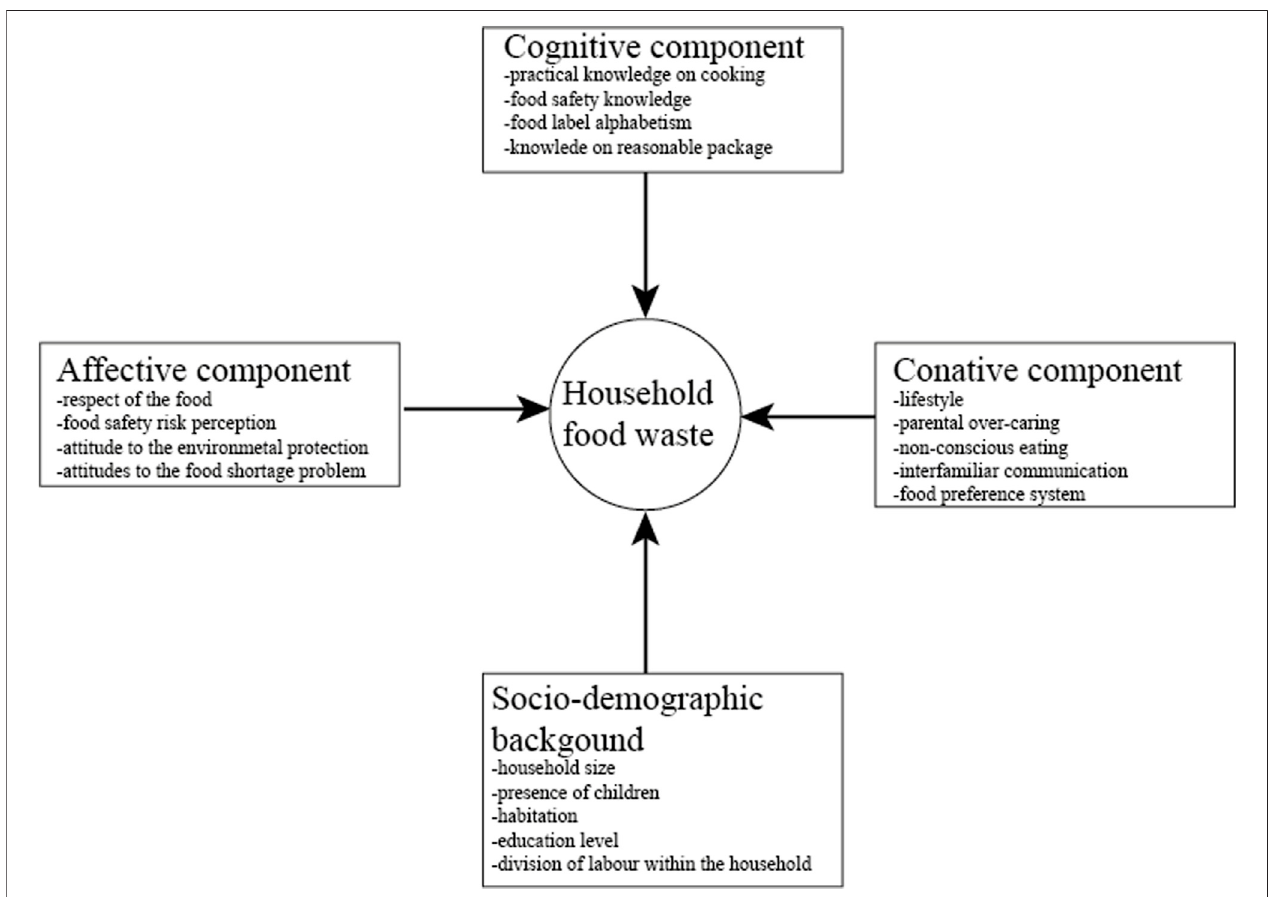
FIGURE 9 | Conceptual model of causes of the household food